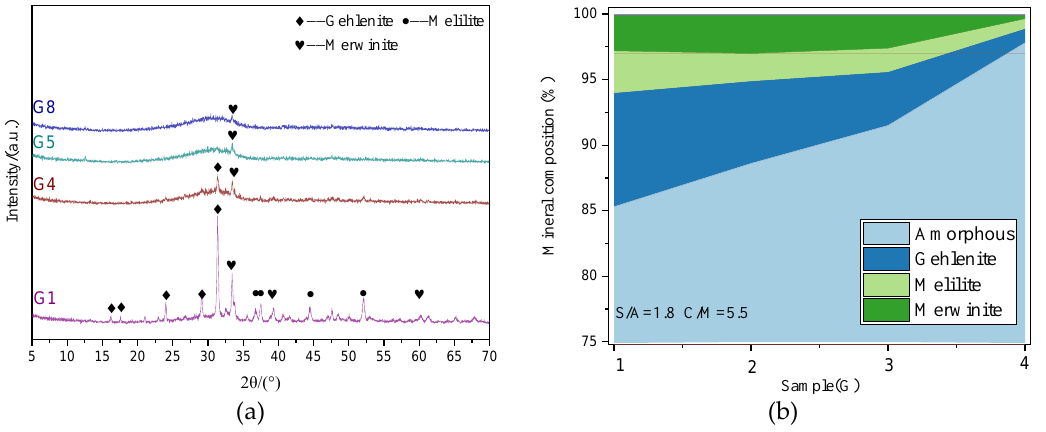
Figure 11. Mineral composition of slag with different amorphous contents: ( a ) XRD patterns; ( b ) quantitative analysis.